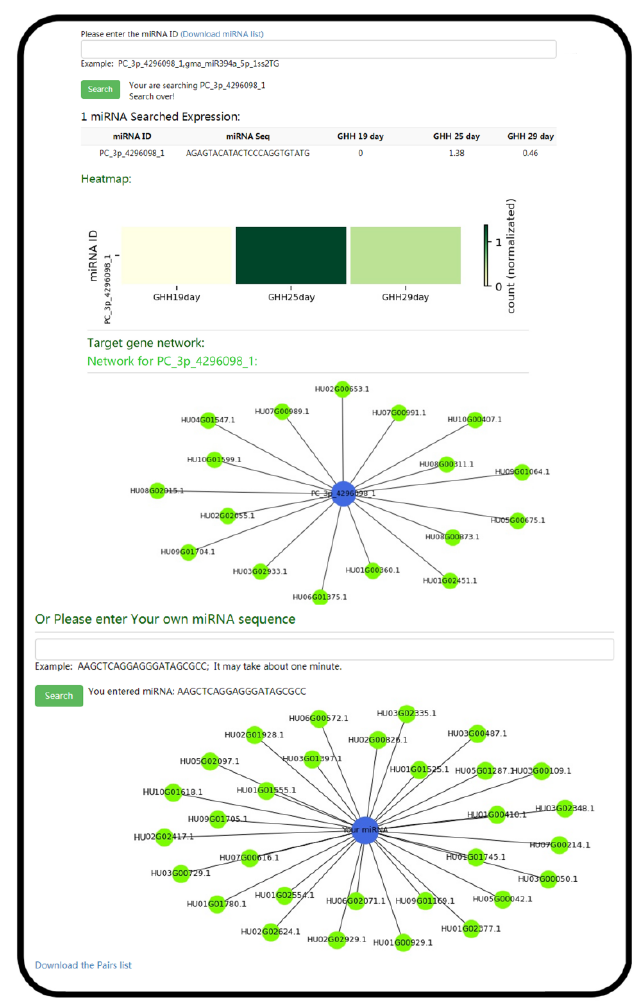
Figure 4. The screenshots of representative resources and action page examples for the ‘miRNA’ module. Expression levels of miRNA and corresponding target genes can be queried by ‘miRNA’ module, users can also perform prediction of target genes by entering miRNA sequences.